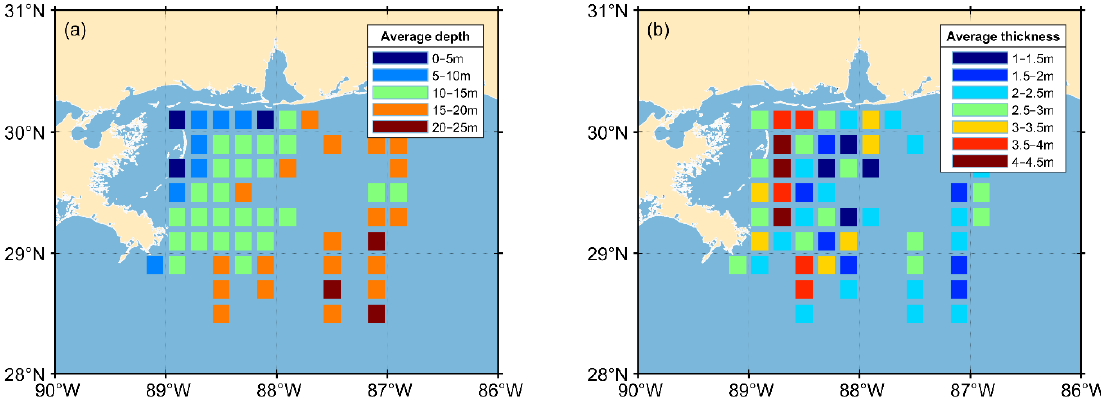
Figure 8. Map of average layer depth and thickness. ( a ) Average depth of layers in different regions; ( b ) Average thickness of layers in different regions.